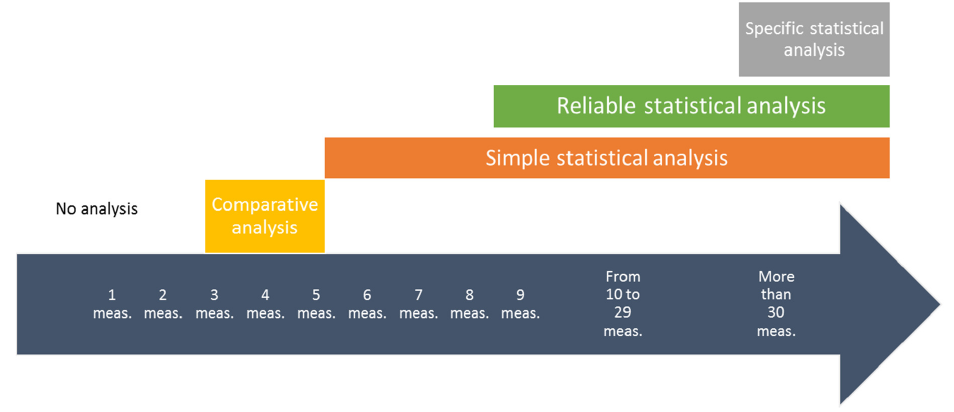
Figure 2. The number of measurements per SEG and the quality of the statistical analysis.